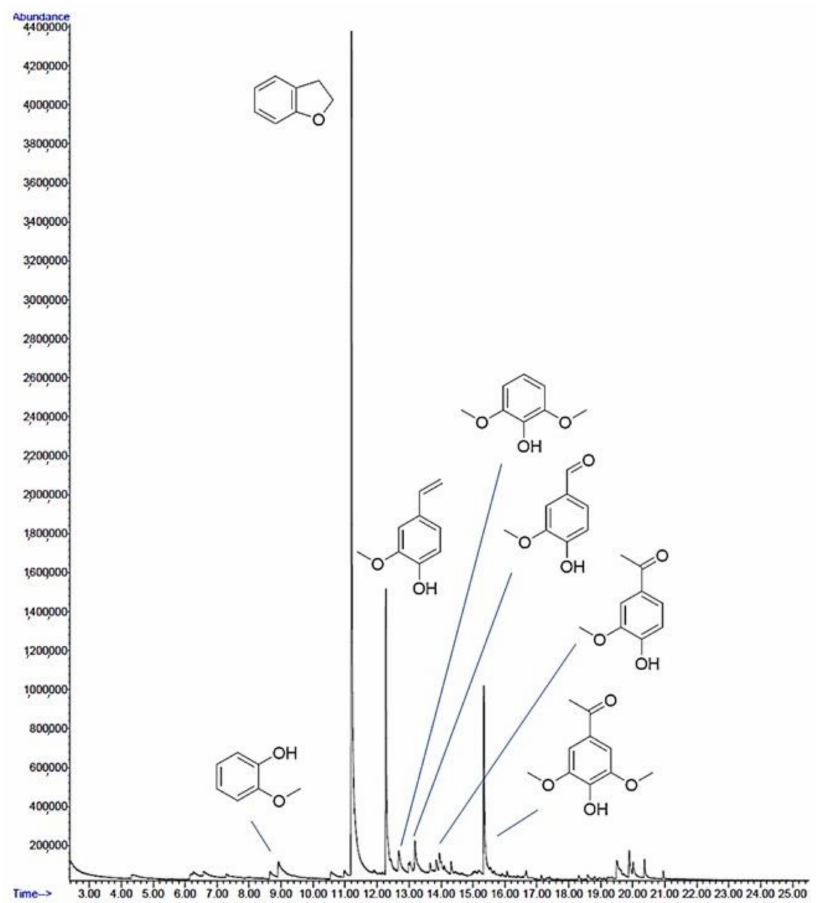
Figure 8. GC–MS chromatogram of liquid fraction after lignin precipitation.